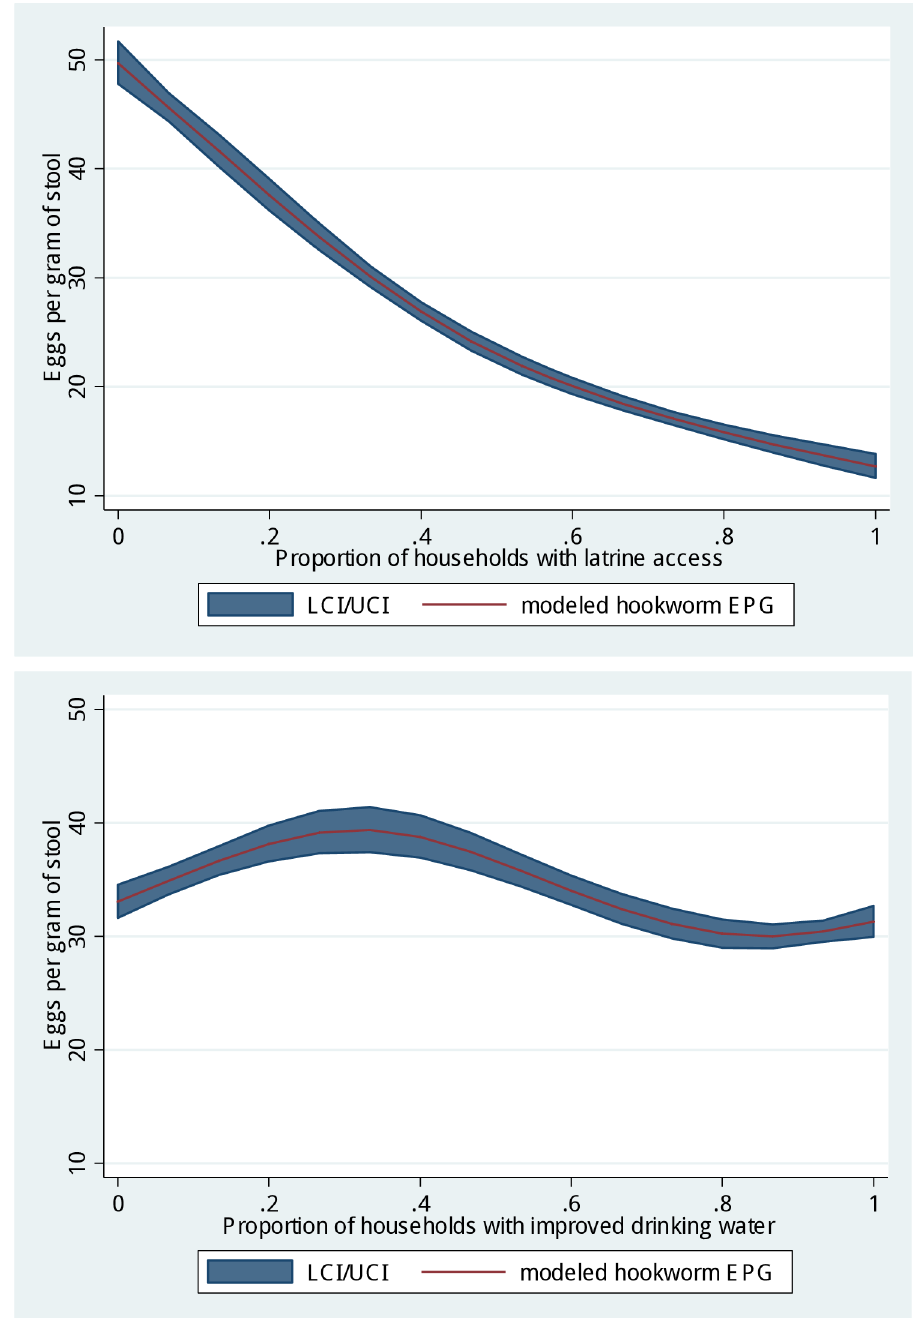
Fig 1. Relationship between individual-level intensity of infection (eggs per gram of stool) and community-level WASH